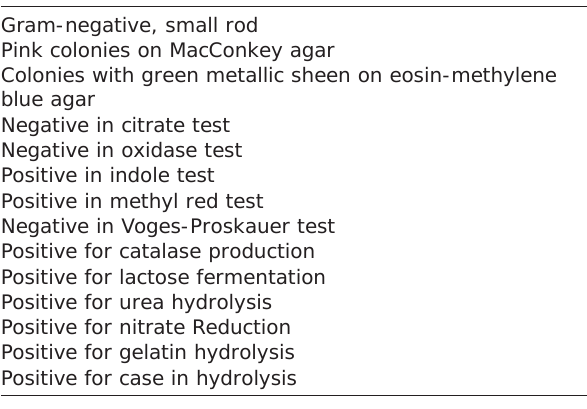
Table-1: Results of biochemical tests used for identification of Escherichia coli .